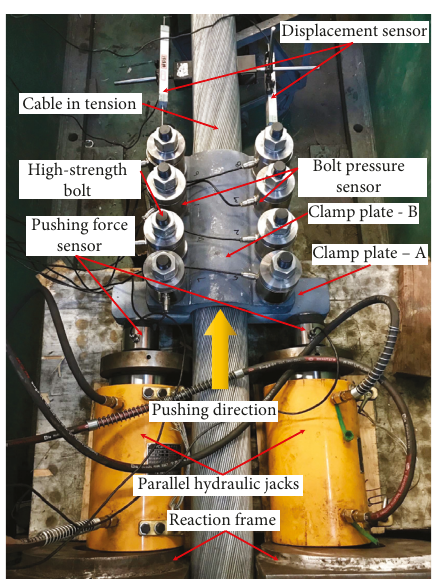
Figure 12: The testing system of the clamp-cable